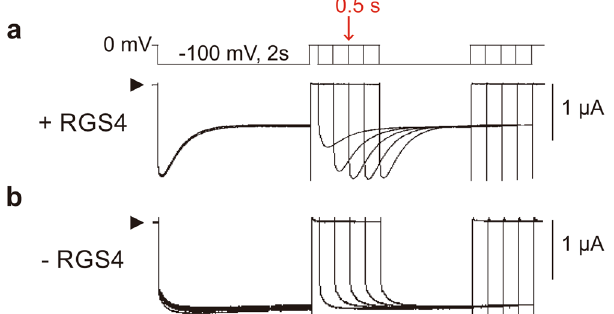
Figure 3. Effects of RGS4 on the recovery of GIRK currents from desensitization. ( a , b ) Pilocarpine (100 µ M)- induced GIRK currents in oocytes expressing M2 muscarinic receptor, Kir3.1/Kir3.4 with ( a ) and without ( b ) RGS4 were recorded with a protocol shown above. Current were recorded with two hyperpolarizing pulses from 0 mV to − 100 mV for 2 s which were separated by an interpulse of 0 mV for a duration range of 0.1, 0.3, 0.5, 0.7 and 0.9 s. The fully recovery of GIRK current from the desensitized state can be observed when interpulse (0 mV) duration is longer than 0.5 s. Time constant for the recovery was fitted with exponential curve and discussed in the result